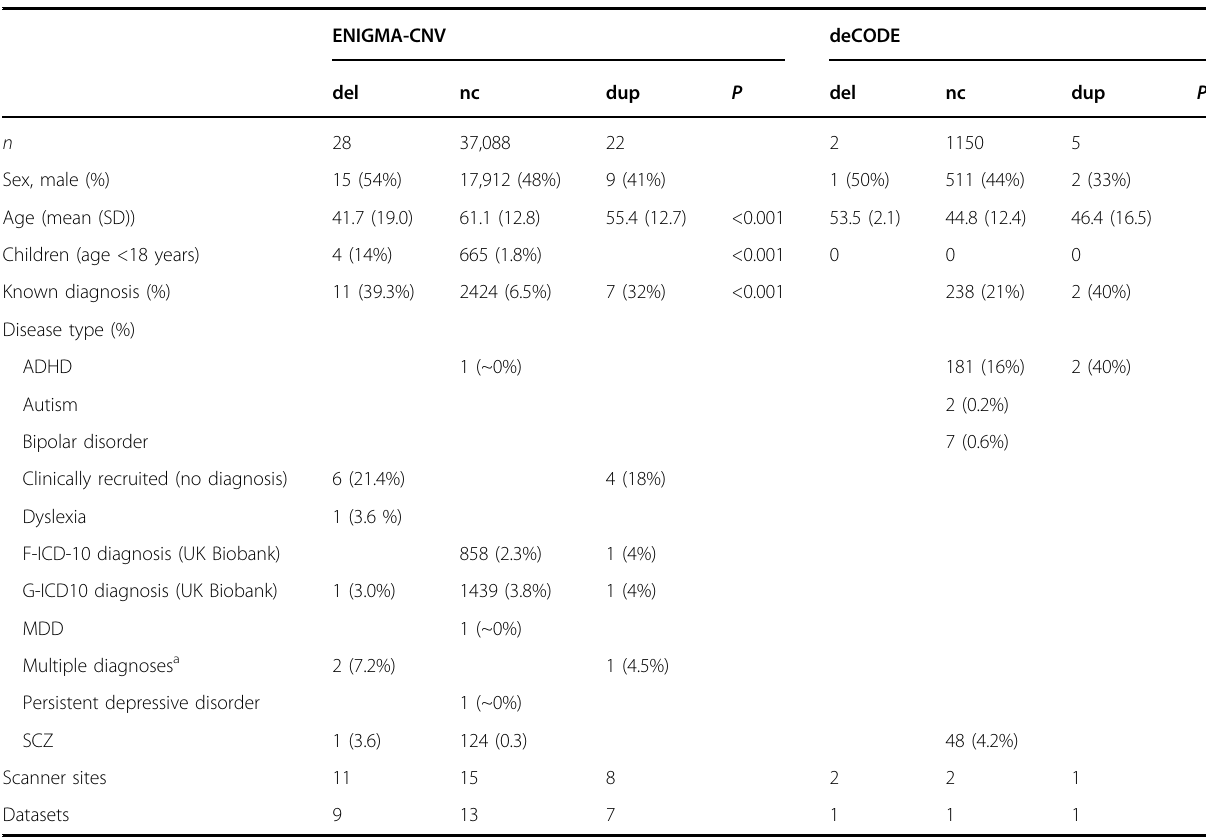
Table 1 Demographic